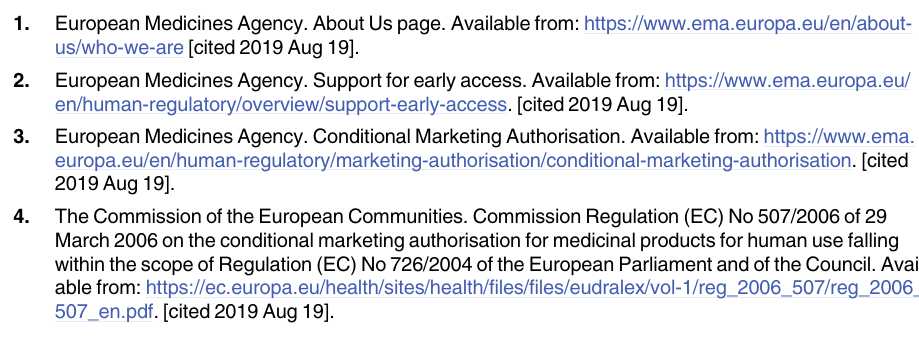
S1 Table. Summary information on products granted CMA or undergoing AA (January 1, 2011–December 31, 2018). AA, accelerated assessment; ‘Ciani’, Ciani and colleagues; CMA, conditional marketing authorisation; EPAR, European Public Assessment Report; F&P, Flem- ing and Powers; HCC, hepatocellular carcinoma; NA, not applicable; PASS,